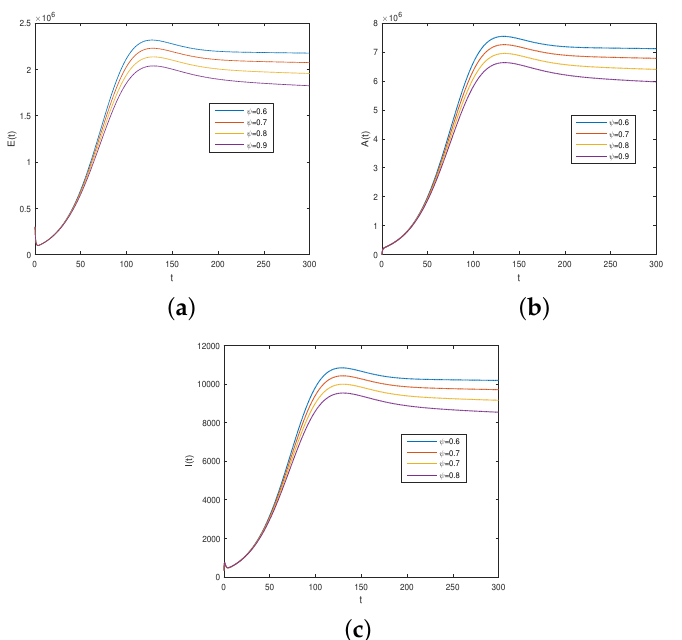
Figure 8. Vaccination efficacy rate on infected compartment ψ with η = 0.95. Subfigures ( a – c ) describes the dynamics of exposed, asymptomatic, and symptomatic individuals respectively. Figure 9 represents the natural immunity loss impact on the infected compartments. With less natural loss of immunity of the individuals, the number of infected people decreases.